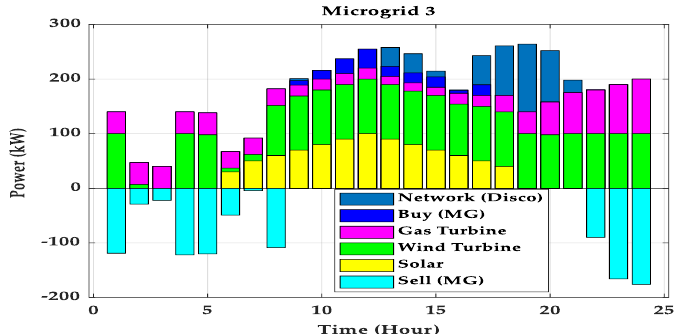
Figure 10. Microgrid 3 ’s load curve.